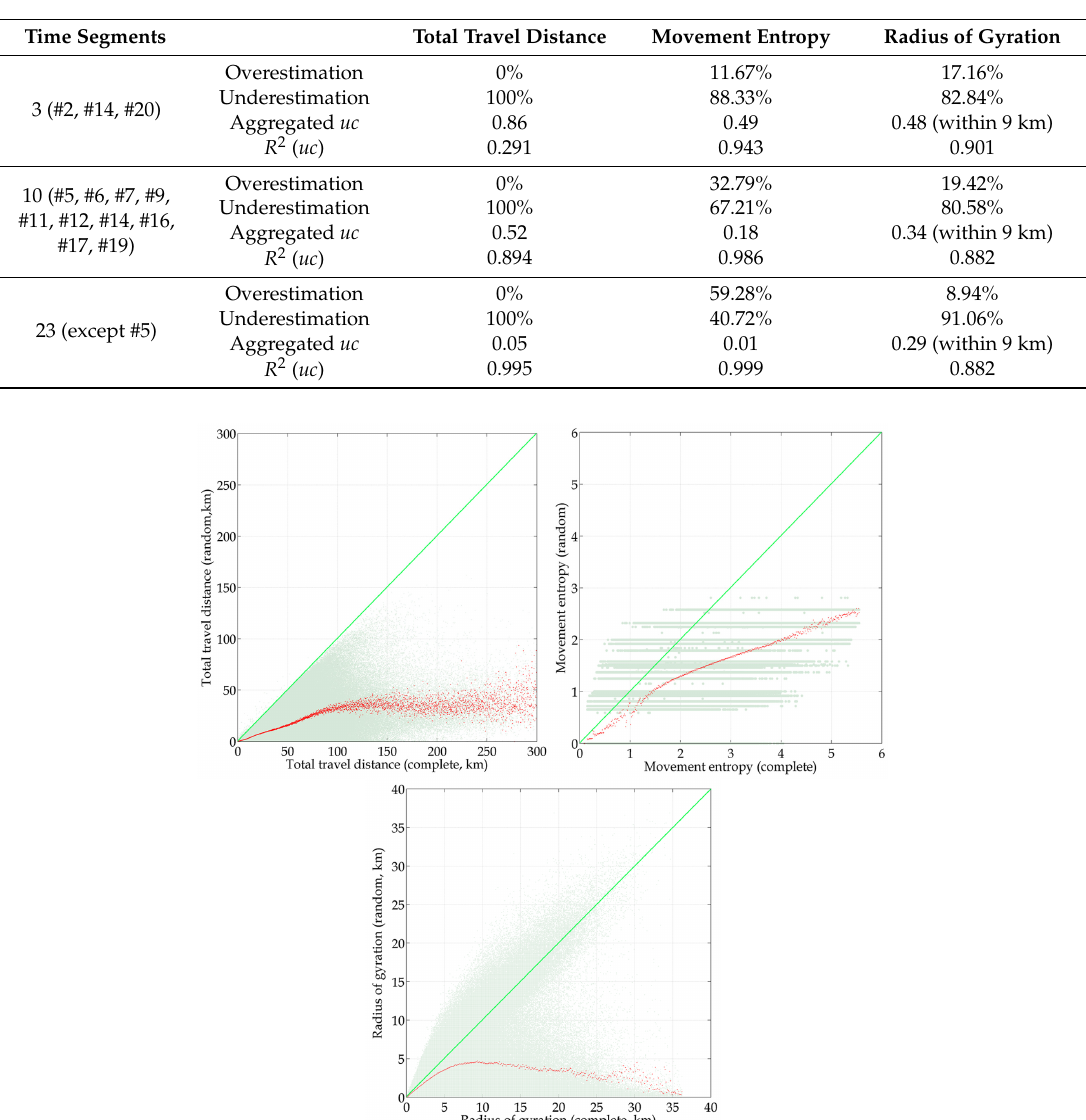
Table 2. Mobility indicator statistics for different random time segments.